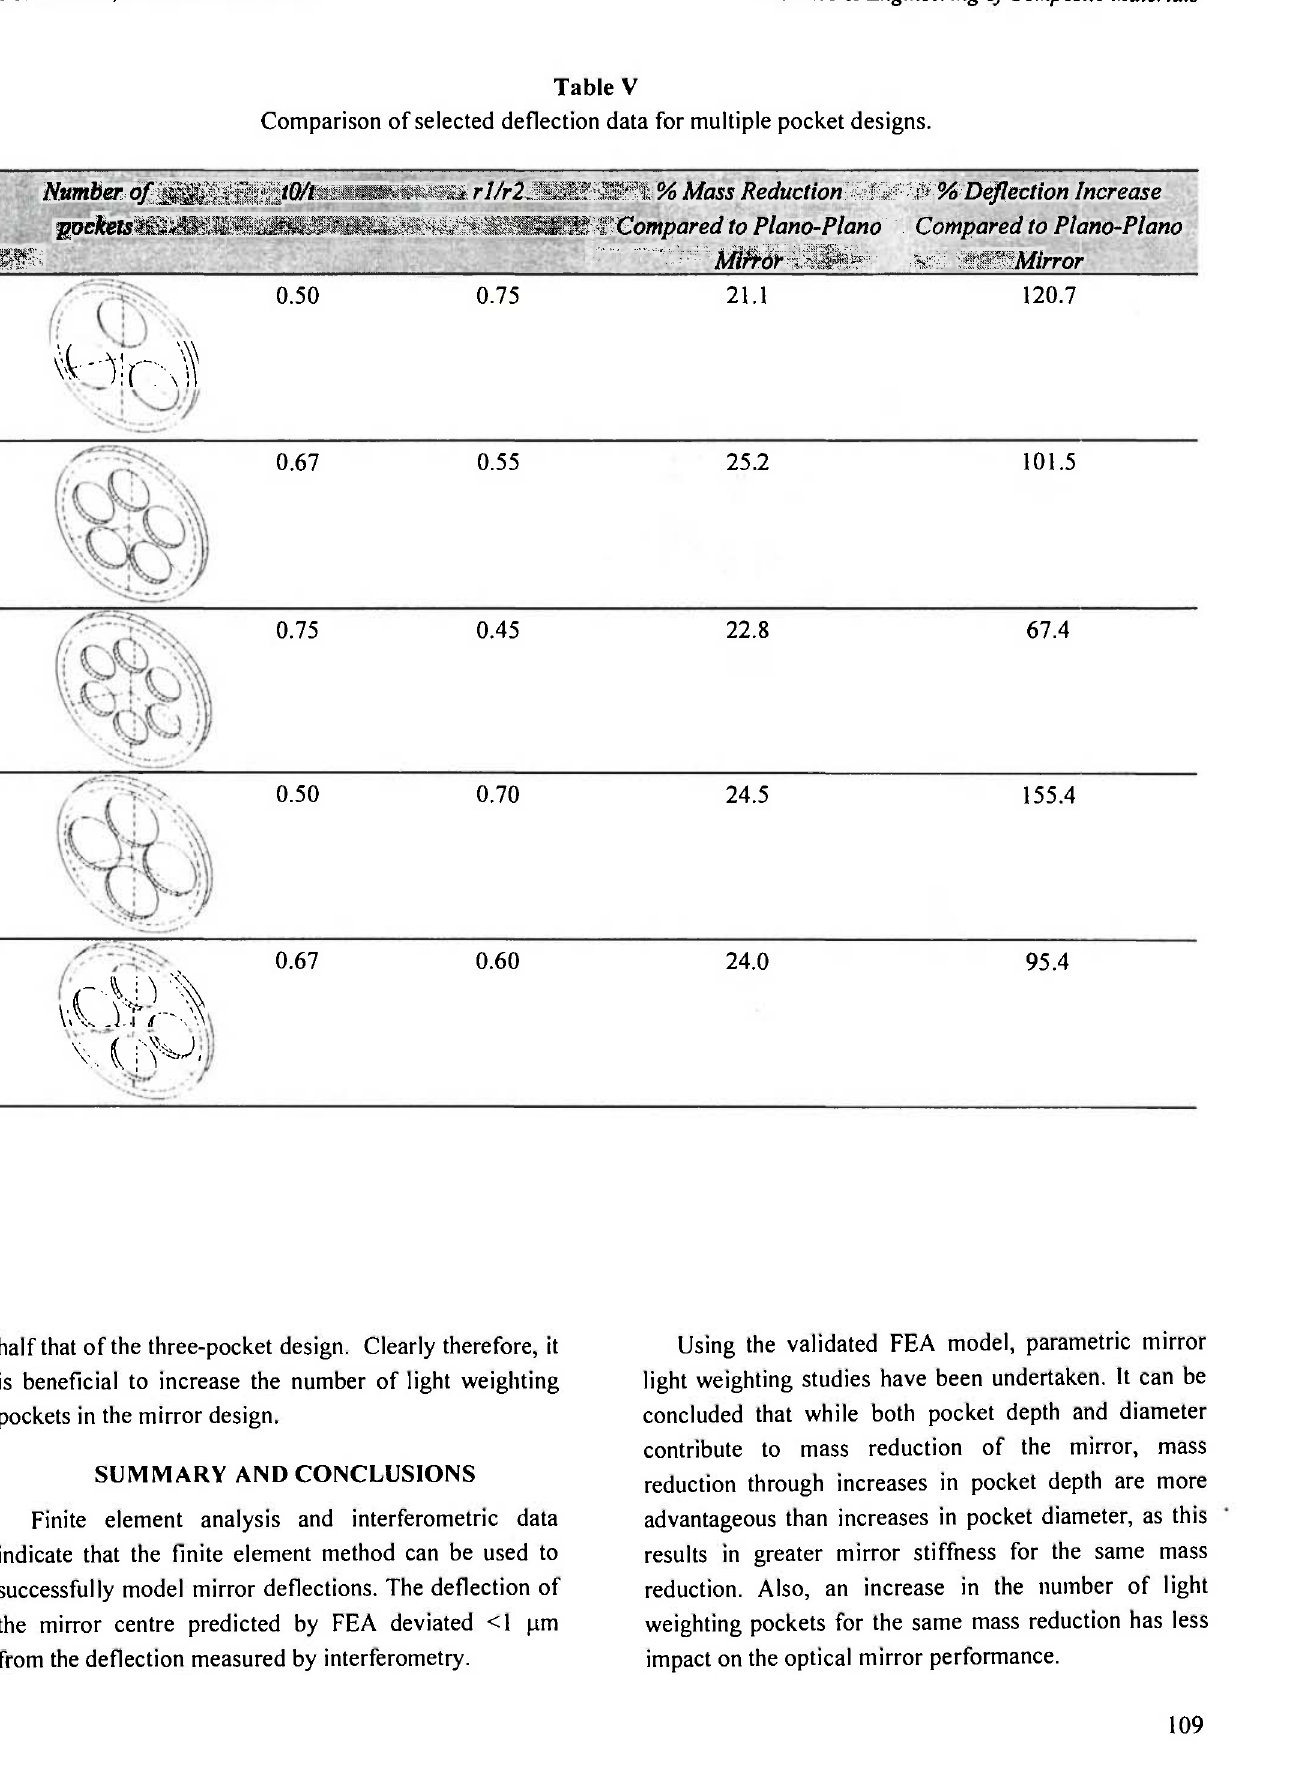
Comparison of selected deflection data for multiple pocket